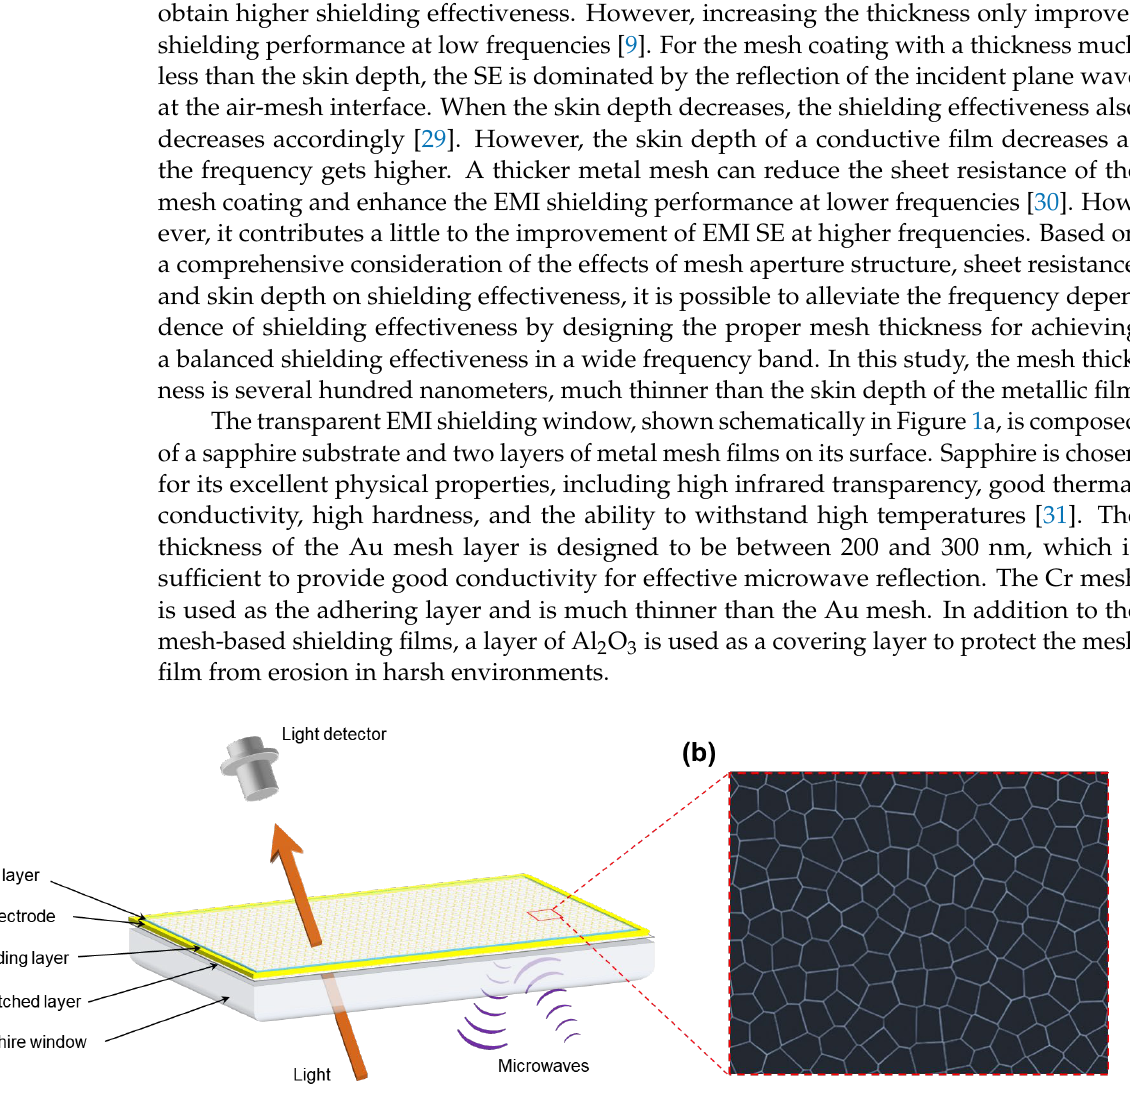
Figure 1. Design of the IR transparent EMI shielding window. ( a ) Schematical illustration of the structure design and function of IR transparency and microwave reflection. ( b ) Mesh pattern of irregular